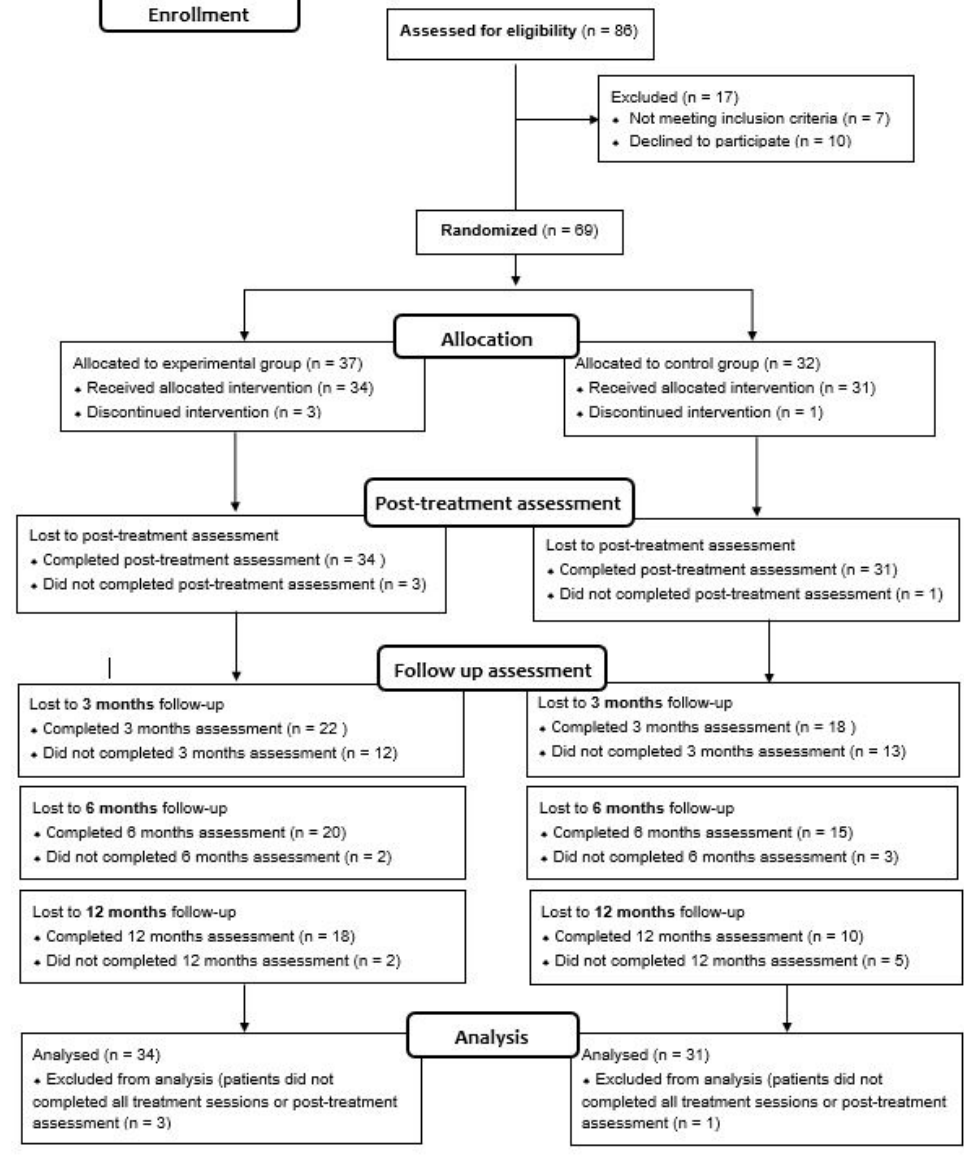
Figure 1. The CONSORT flow diagram.